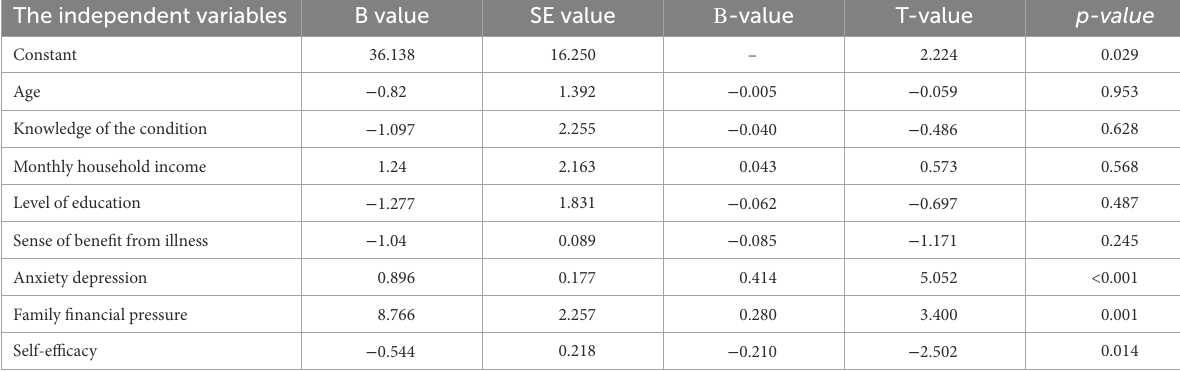
TABLE 4 Multiple linear regression analysis of influencing factors of care burden of caregivers of pancreatic cancer patients. The independent